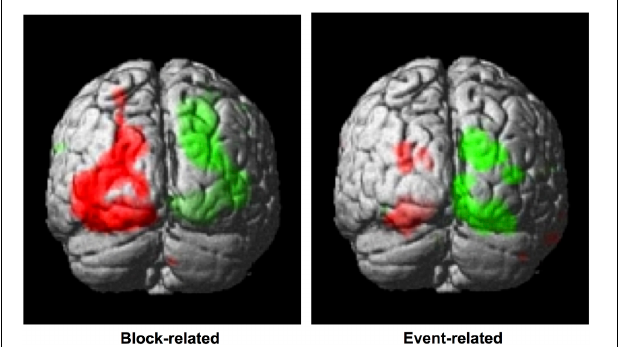
FIGURE 3 | Whole-brain analyses. Left: Block-related contrast of left vs. right-cued conditions, under similar stimulus conditions (highlighted in green and red, respectively). These attention-driven areas were used to mask visual areas distinguished using retinotopy, to define our regions of interest. Right: Event-related contrast of left vs. right color-change transients (green and red, respectively). Results are superimposed on a standard template, with a threshold of p < 0 . 001